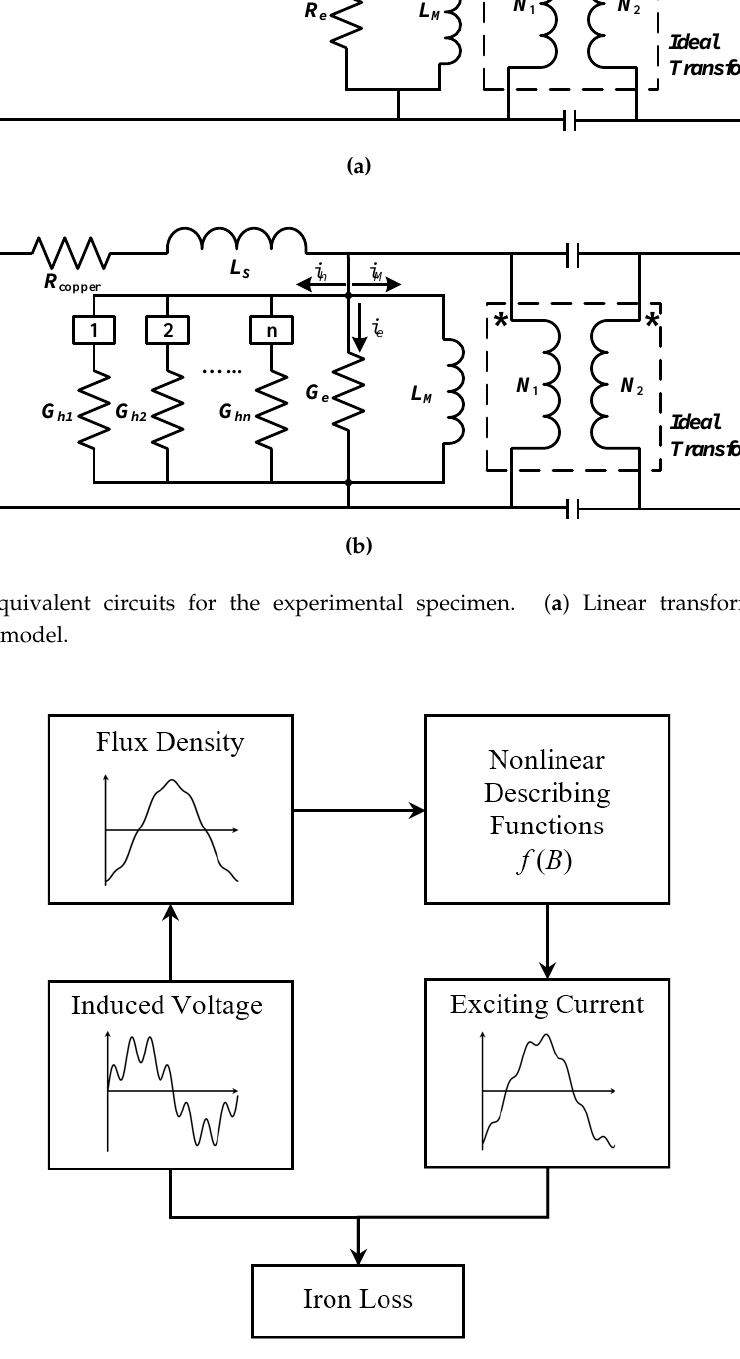
Figure 3. Process of the iron loss